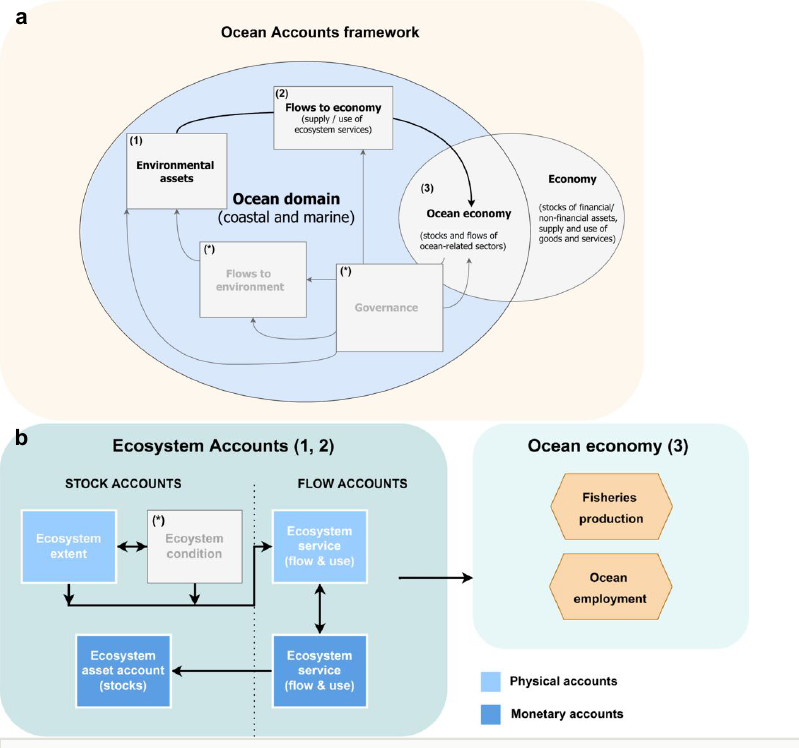
specific focus on ecosystem accounts and their links to the ocean economy. a : An overview of the Ocean Accounts framework, subset to three accounting table groups